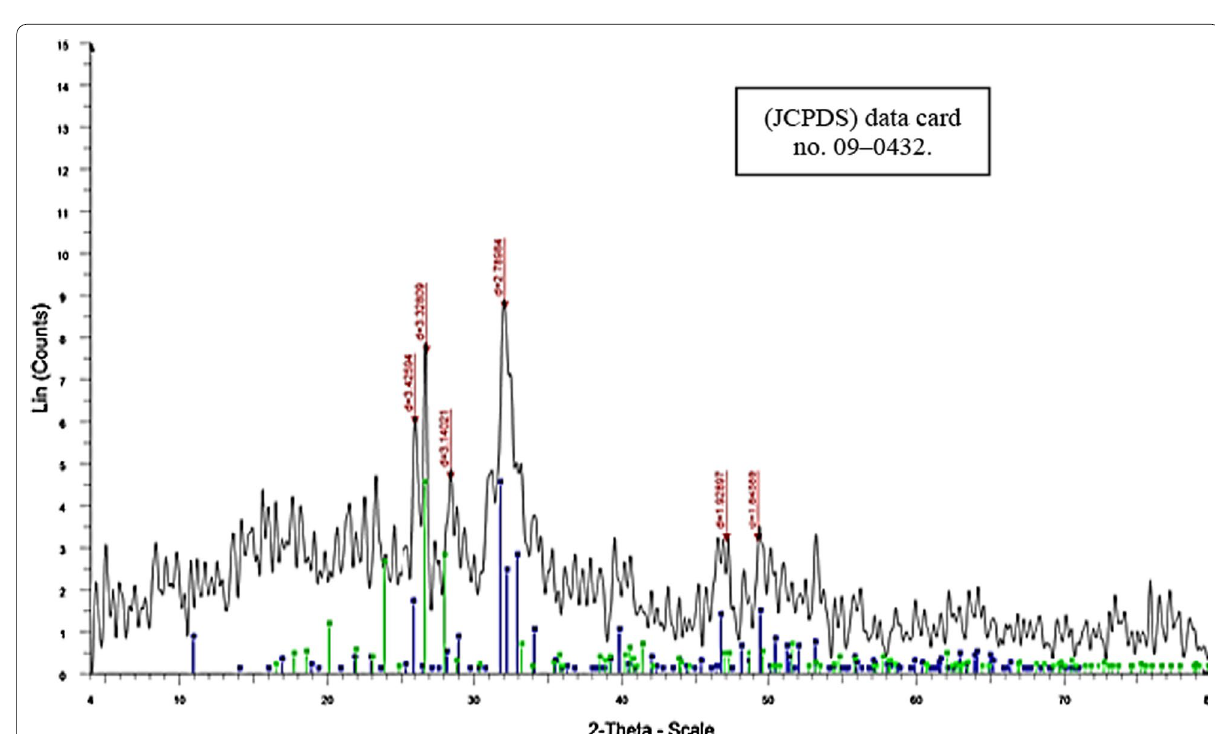
scope (TEM) photomicrograph of the prepared